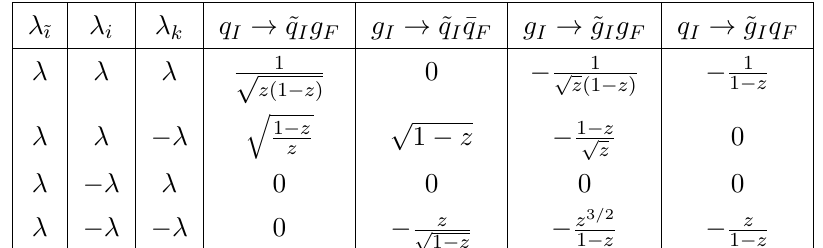
( z ) that appear in i → ˜ ık